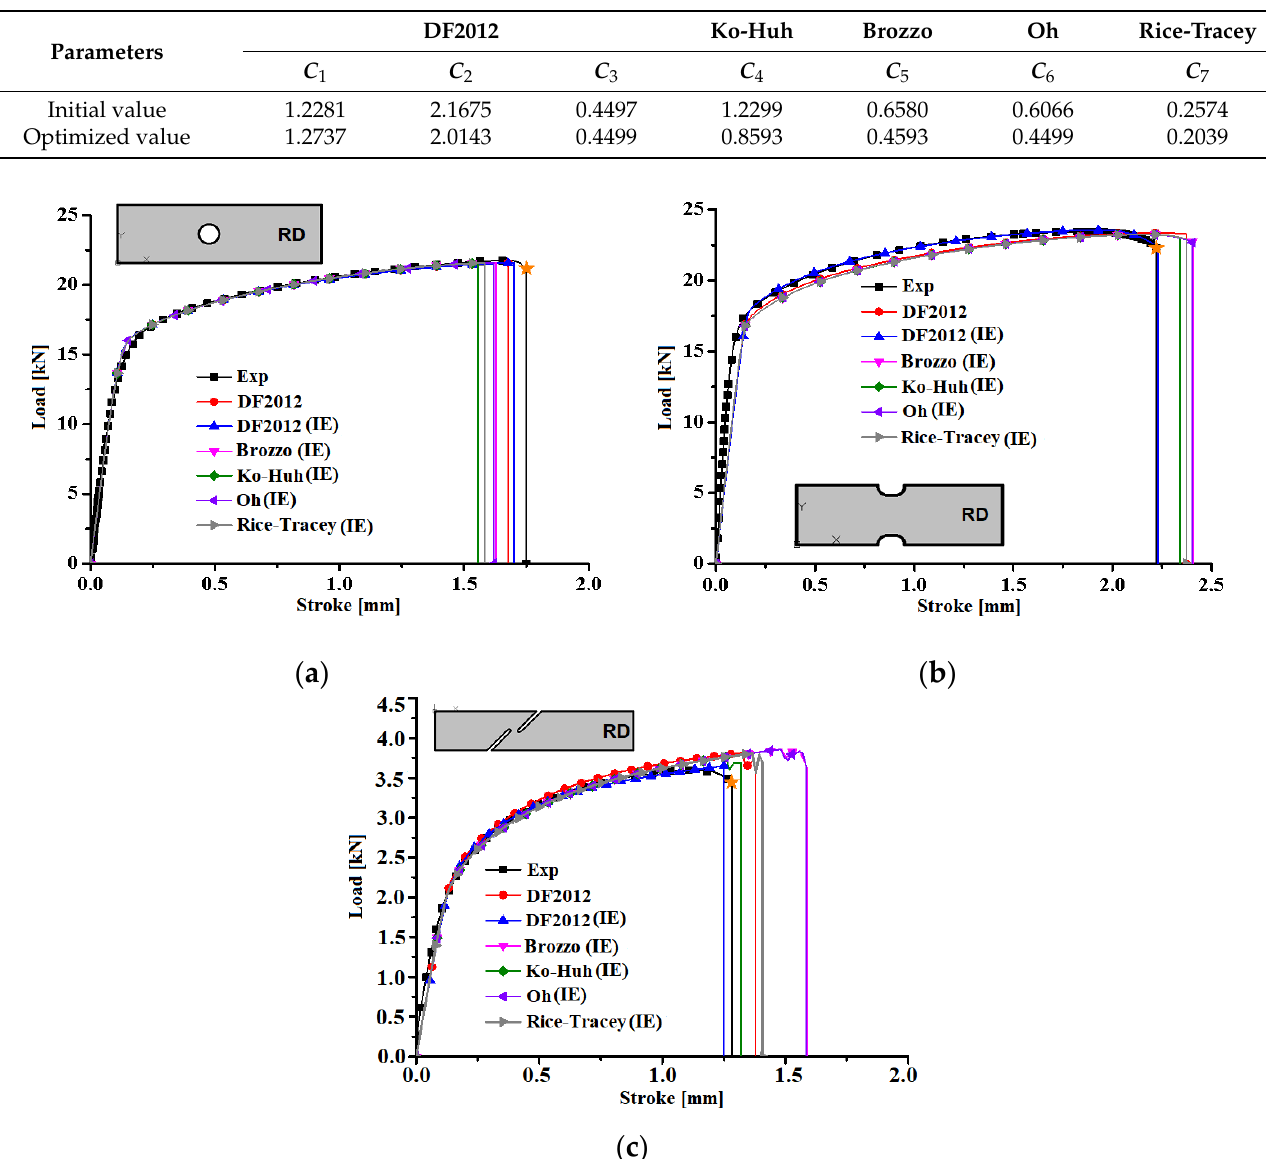
Figure 16. Error comparison of load-stroke predicted by different ductile fracture criteria.